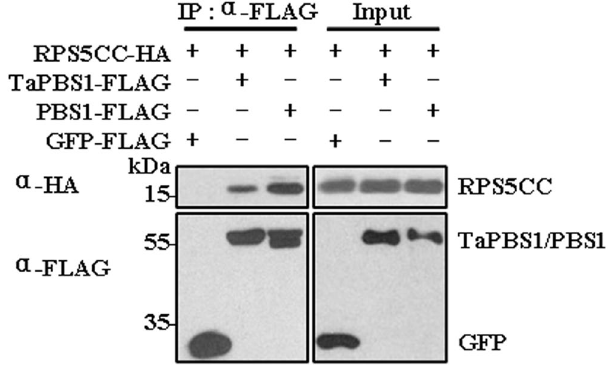
Figure 3. TaPBS1 associates with the CC domain of RPS5. TaPBS1/PBS1-FLAG and RPS5-CC-HA were co- expressed in Arabidopsis protoplasts, and TaPBS1/PBS1 was precipitated with an anti-FLAG antibody. The associated proteins were analyzed by Western blotting with an anti-HA antibody. GFP-FLAG was used as a negative